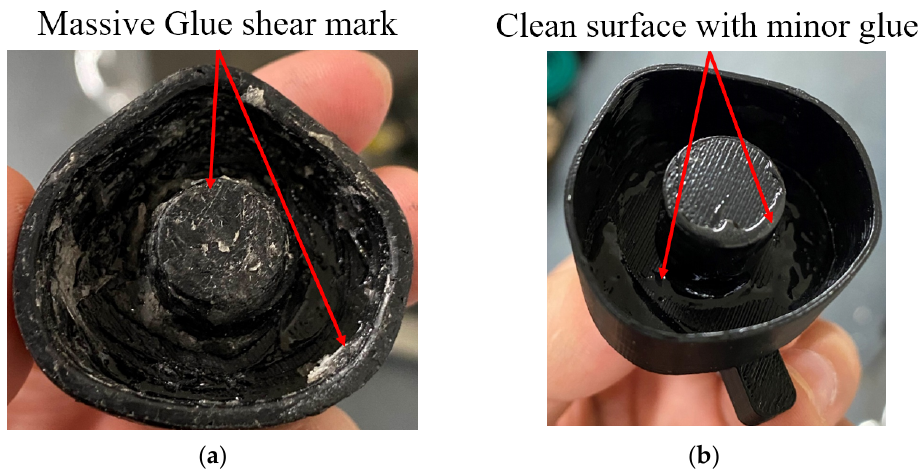
Figure 16. Implant surface with ( a ) adequate bonding and ( b ) insufficient bonding.